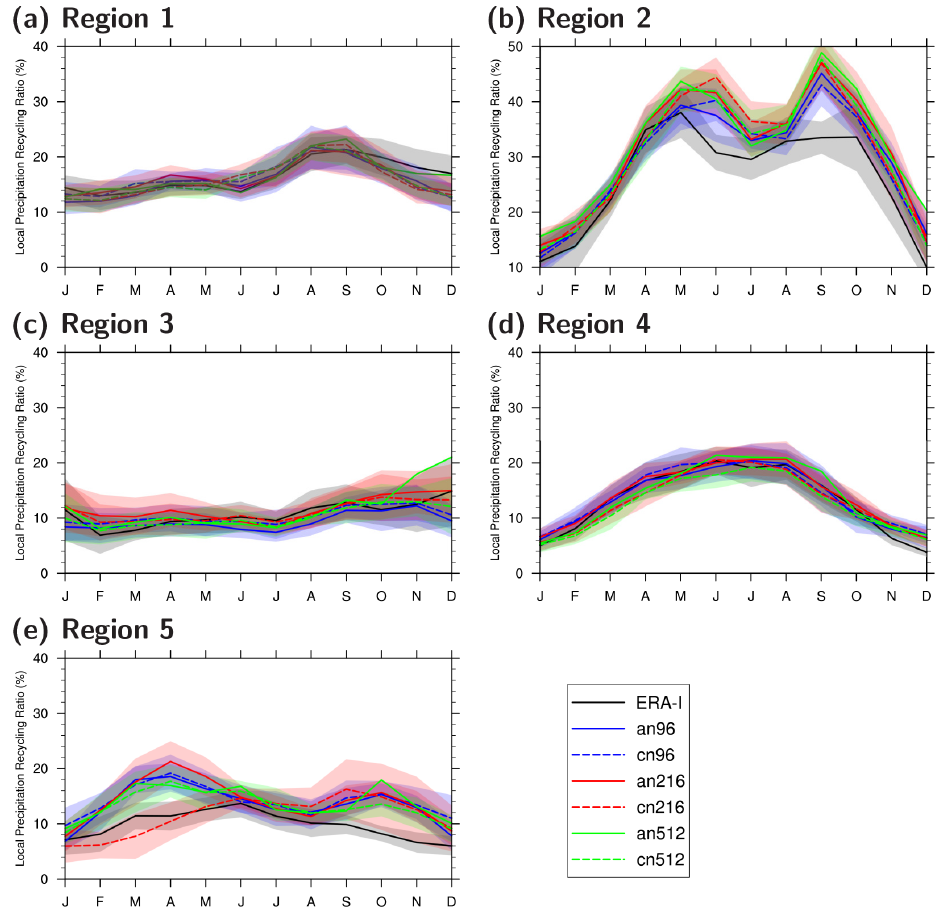
Figure 5. Annual cycle of the mean precipitation recycling ratio for EA subregions calculated from ERA-Interim and simulations (units: %). Shaded bands represent ± 1 σ